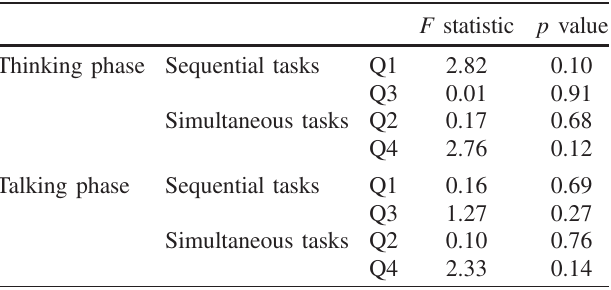
TABLE IV. Statistical results from one-way ANOVA compar- ing within-diagram gaze transitions between students who identified all the correct concepts and those who did